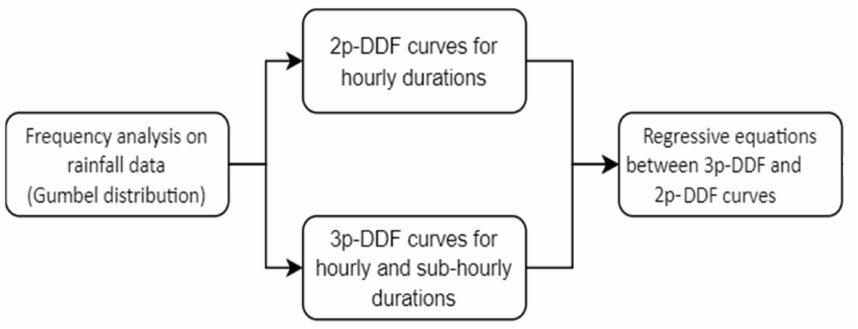
Figure 1. Flowchart of the methodology